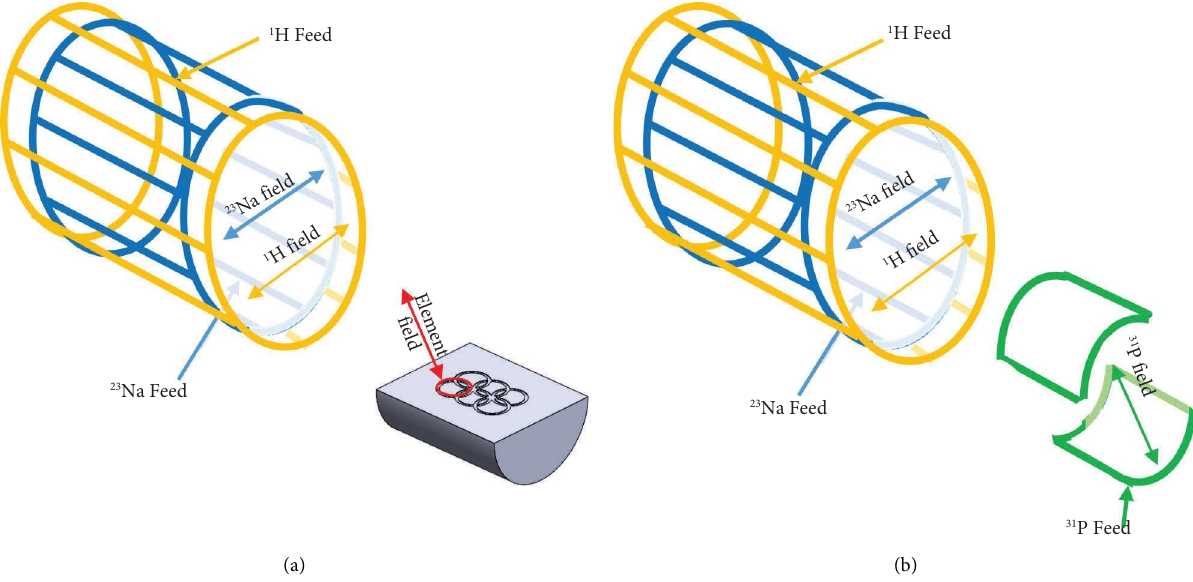
Figure 3: (a) Graphic showing the double-tuned birdcage net feld directions and the orthogonal feld orientation of the planar array element on the phantom including the feed locations. (b) Graphic showing the triple-tuned birdcage net feld directions and the orthogonal feld orientation of a saddle insert including the feed